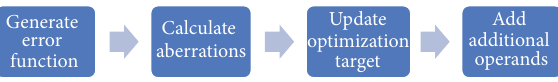
Figure 3: Aberration subtraction